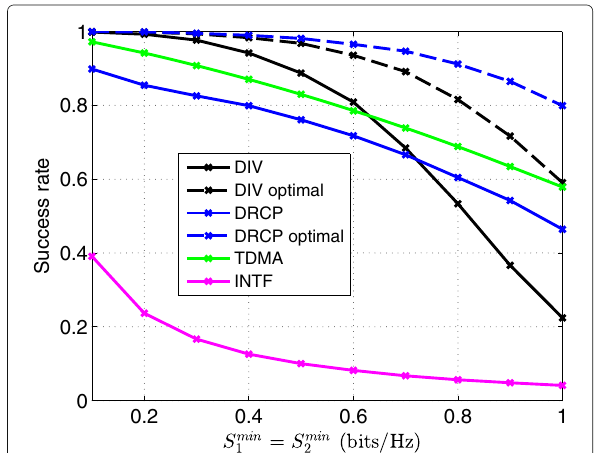
spectral efficiency, energy efficiency, and success rate, under the assumption of a strong overhearing link typical of dense networks. We have also provided a low- complexity power control strategy that achieves a perfor- mance close to the optimal for each of these approaches.